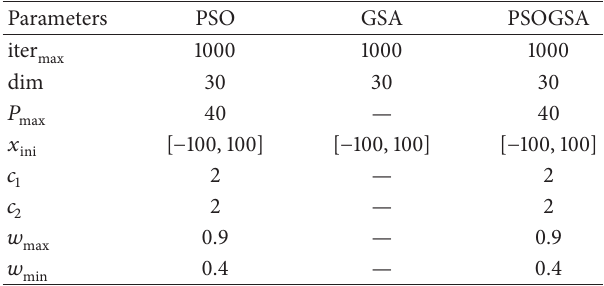
Table 1: Parameters value of PSO, GSA, and